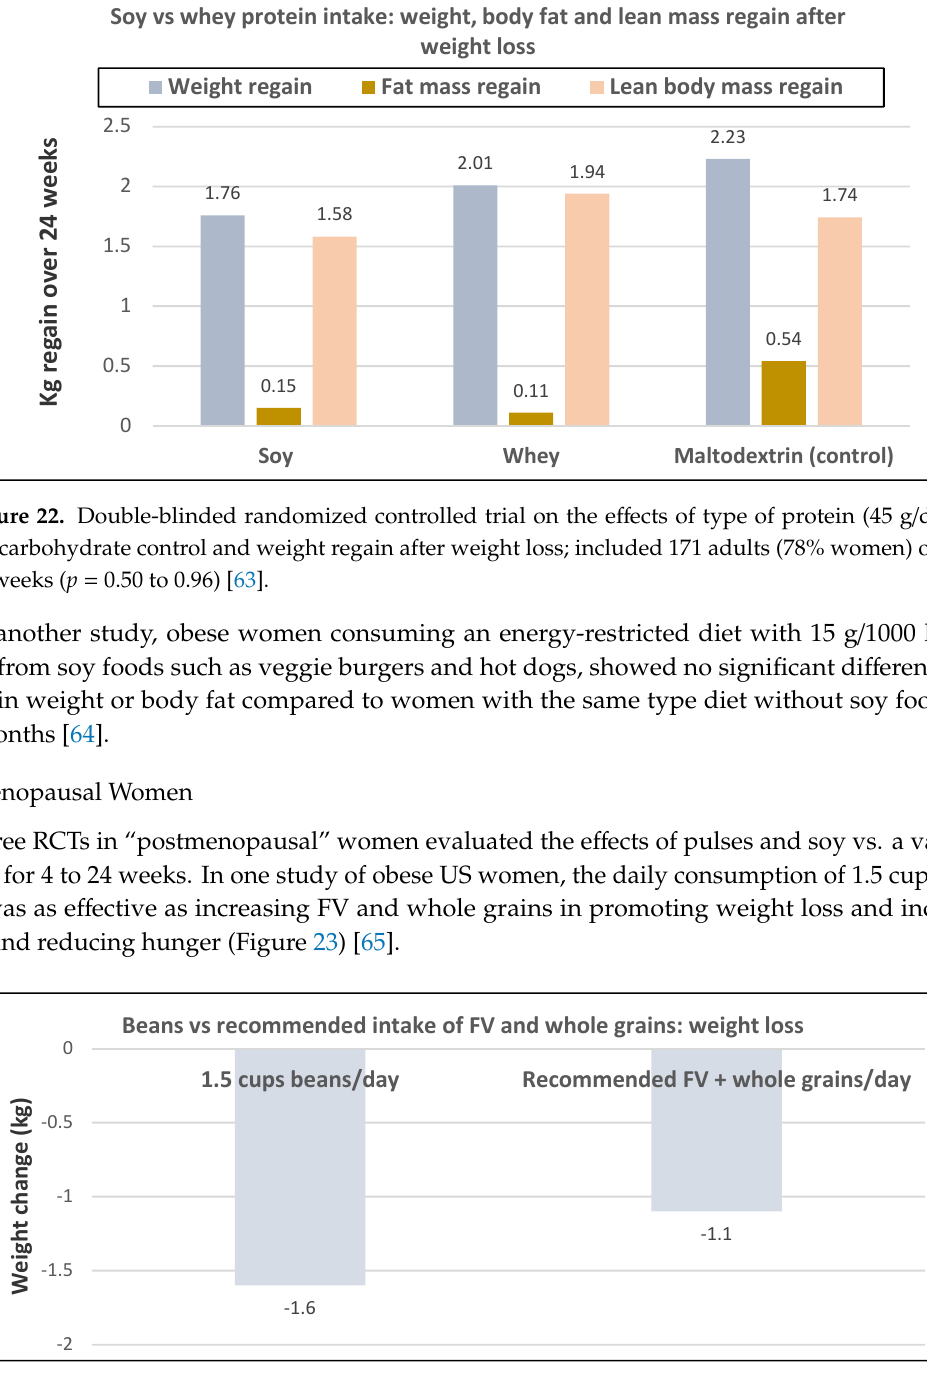
Figure 23. Beans compared to the recommended intake of fruit and vegetable (FV) and whole grains on weight loss in 20 subjects (90% women; mean 47 y and BMI 31) after four weeks (both diets p < 0.001; mean fiber 28g/day) [65].